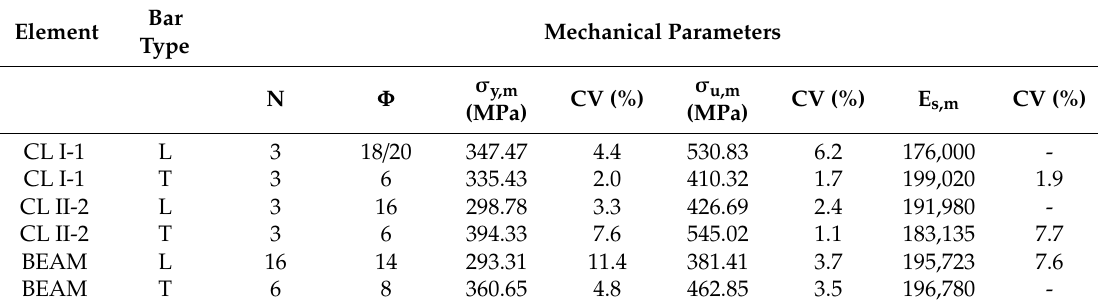
Table 2. Results from the tensile tests performed on the steel